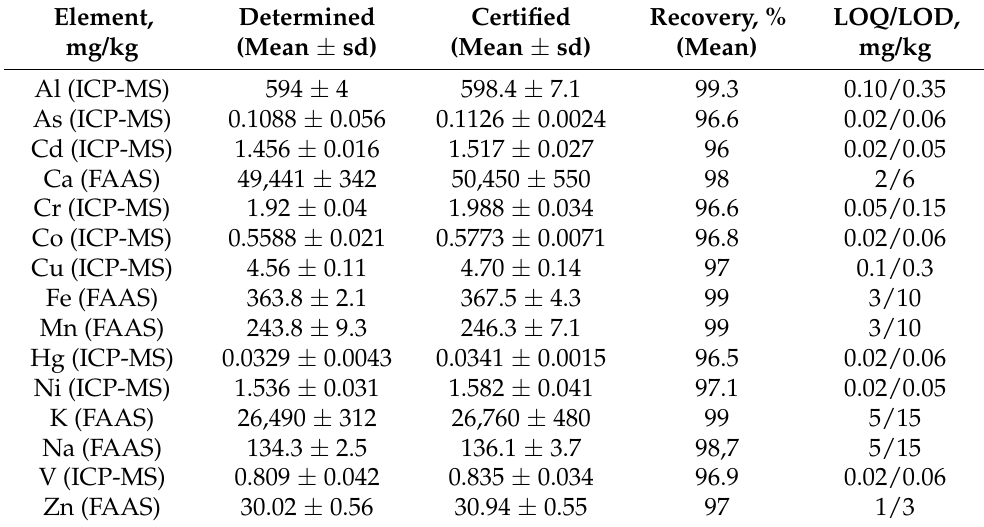
Table 1. Results and recoveries for chemical element contents (mg/kg) determined in NIST SRM 1573a Tomato leaves (three parallel determinations).